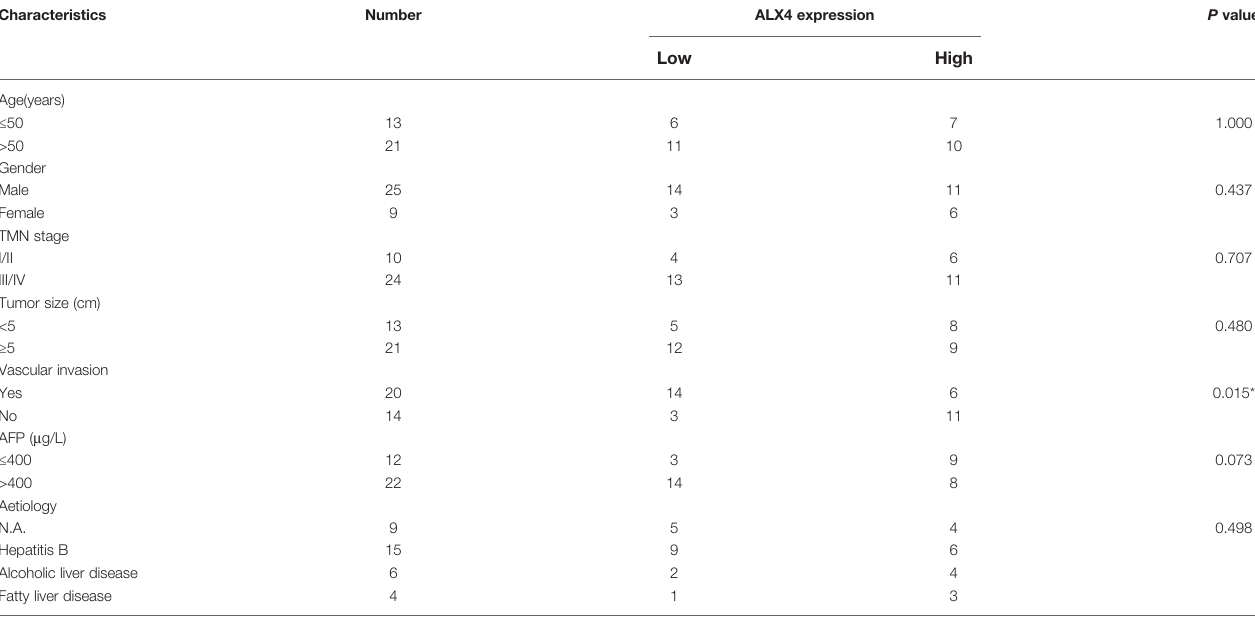
TABLE 4 | Correlation between ALX4 expression and clinicopathological features in 34 HCC patients. Characteristics Number ALX4 expression P